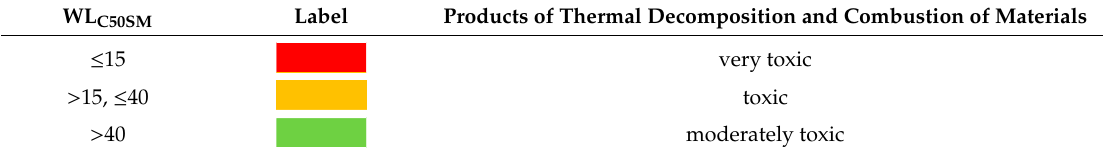
Table 3. Classification criteria for toxic products of thermal decomposition and combustion based on the value of the toxicometric indicator ( W LC50SM ) in accordance with PN-B-02855 [52]. WL C50SM Label Products of Thermal Decomposition and Combustion of Materials